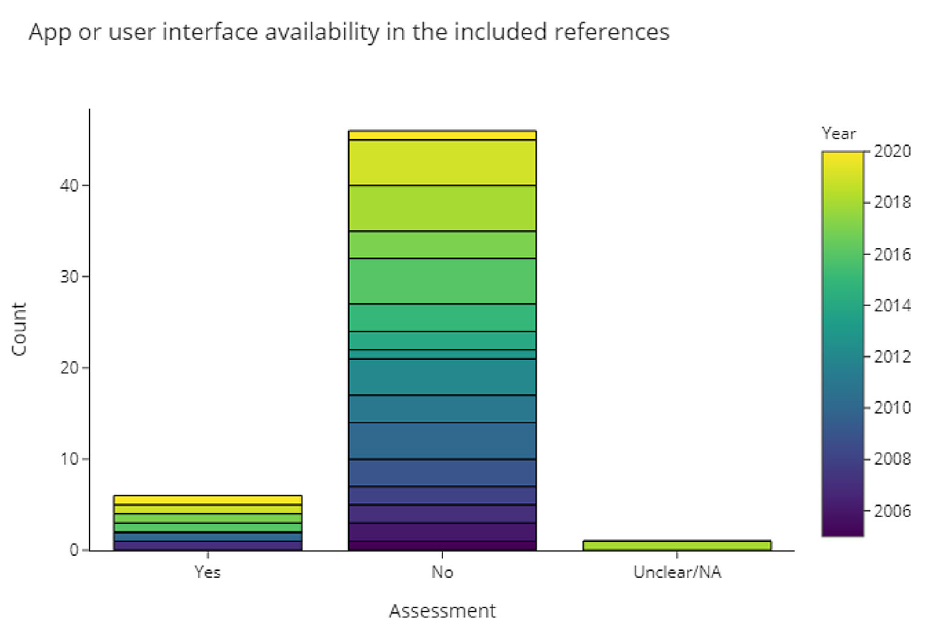
Figure 11. Publications that provide applications with user